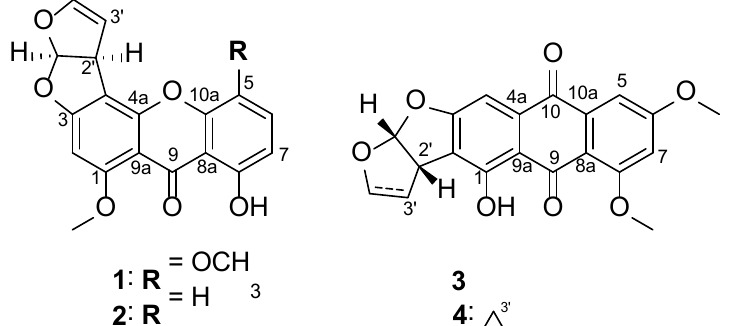
Figure 1. Structure of isolated metabolites ( 1 – 4 ).